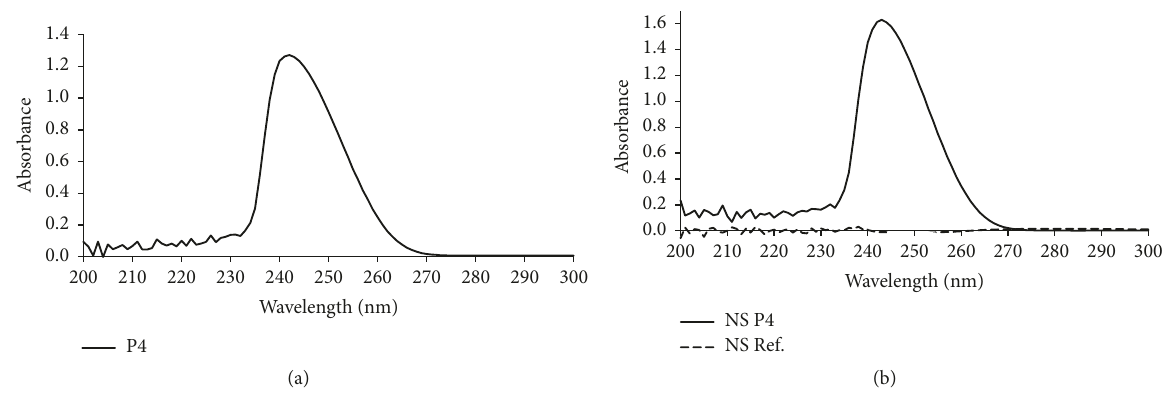
Figure 1: UV absorption spectra of (a) pure P4 and (b) P4-loaded NS (20 mg ⋅ g −1 ) and NS reference (no P4 added).